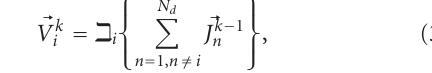
Once the currents have been calculated, those that are located inside the extension are discarded. By doing this we avoid the negative e ff ect of the singular behavior of the currents near the artificially introduced edges. According to our experience an extension with a side length between 0.7 to 1.0 wavelengths is enough to obtain good